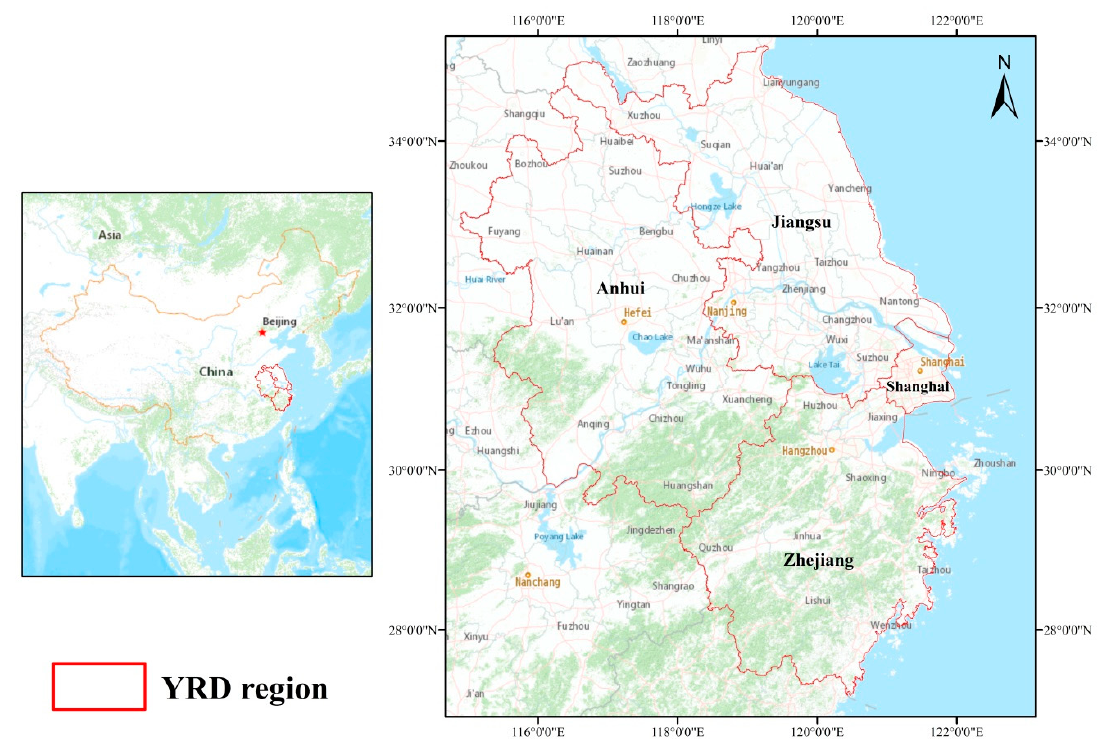
Figure 1. Location of the Yangtze River Delta (YRD) region in China.